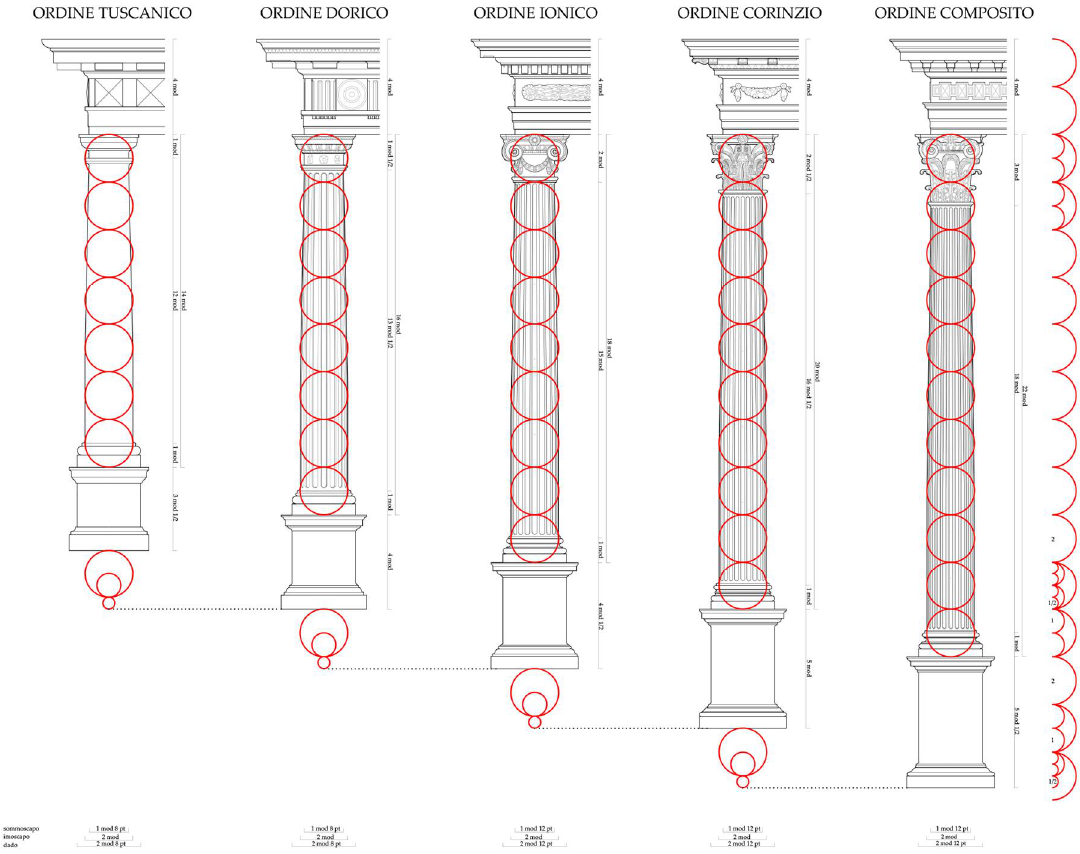
Figure A1. Drawing of the comparison between the architectural orders with the analysis of the reduction